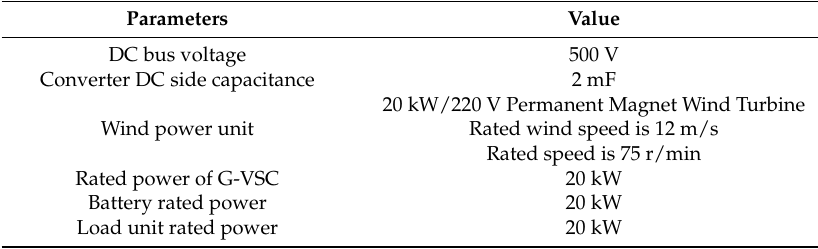
Table 1. Parameters of the model.